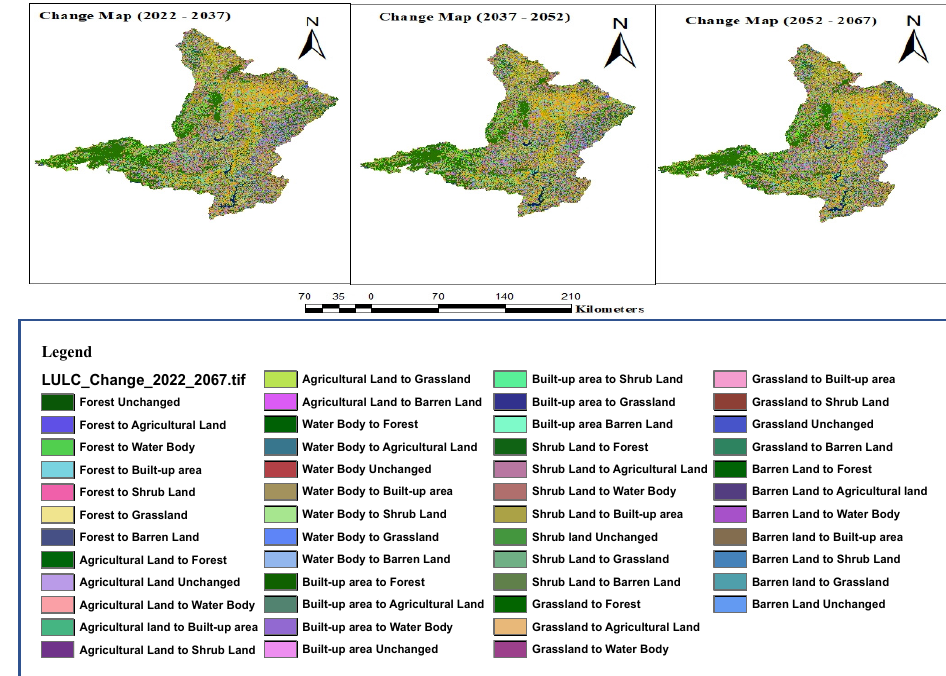
Figure 11. Change maps (2022–2067) .